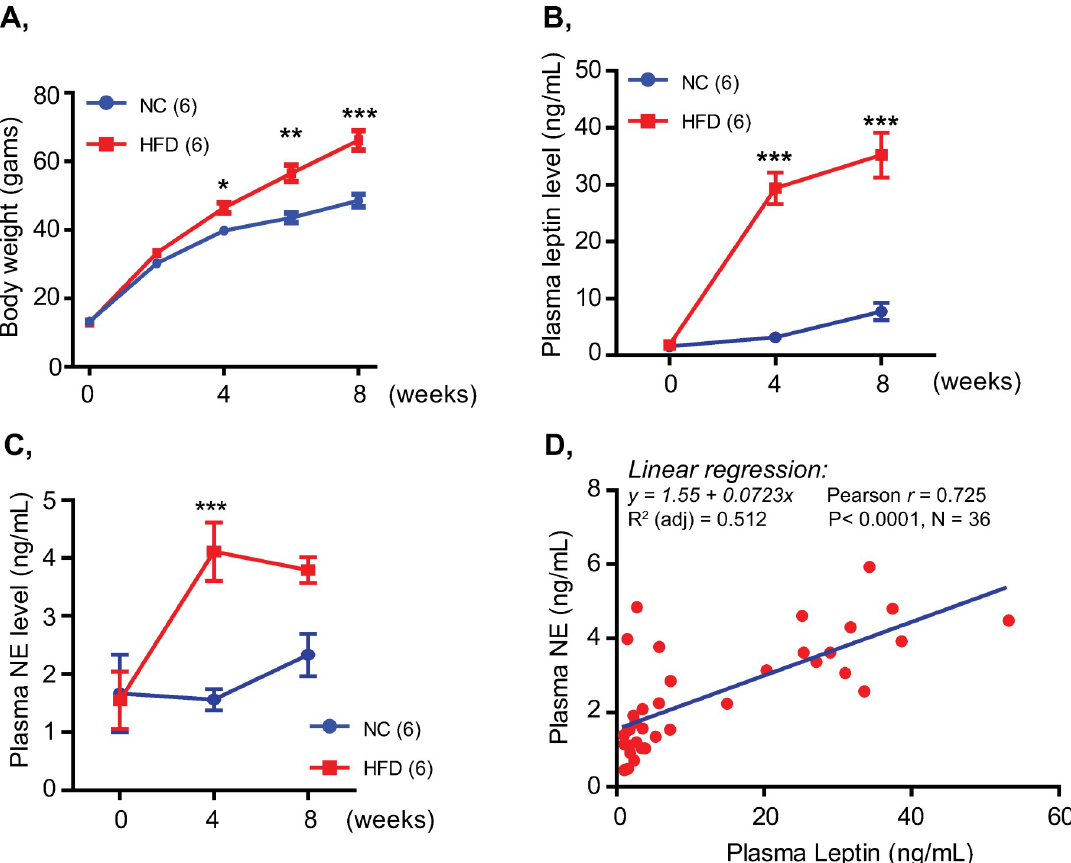
Fig 1. Basal plasma norepinephrine was persistently elevated and highly correlated with plasma leptin in HFD-induced obese mice. A, Body weight of male mice fed NC or HFD for 8 weeks. B, C, Plasma leptin (B) and norepinephrine (NE) (C) levels of mice measured in basal resting condition during 8-week period of HFD feeding. D, Linear correlation analysis of basal norepinephrine and plasma leptin concentrations during HFD-induced obesity. Data are presented as mean ± SEM. Two-way ANOVA with Bonferroni’s post-tests. � P < 0.05, �� P < 0.01 and ��� P < 0.001. Hormone measurement was performed in